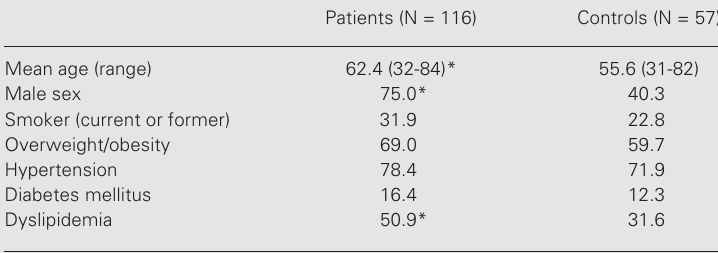
Table 1. Main characteristics of coronary artery disease patients and control subjects.